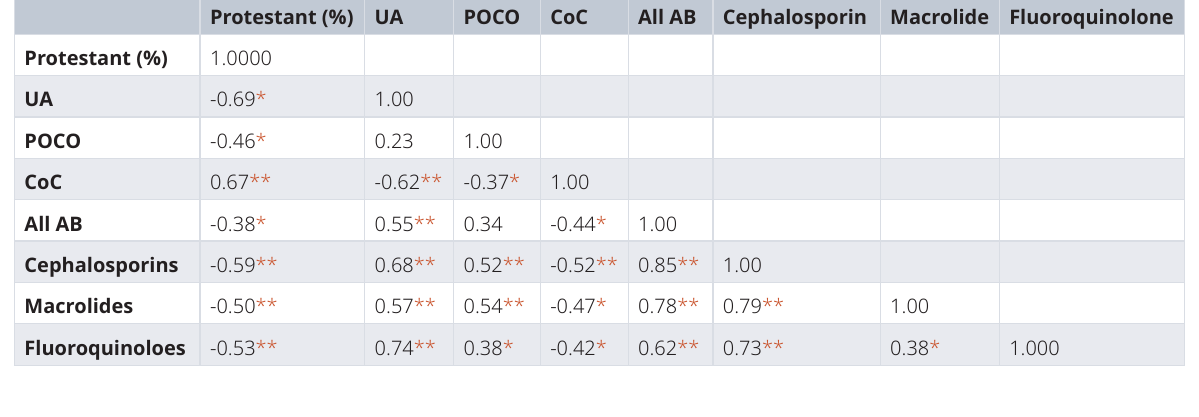
Table 2. Pearson’s correlation coefficients between study variables. Significance levels are highlighted by * for P<0.05, ** for P<0.005. Abbreviations: All AB – All antibacterials, CoC – Control of Corruption; UA- Uncertainty Avoidance Index; POCO – Performance Oriented vs. Cooperation Oriented society.